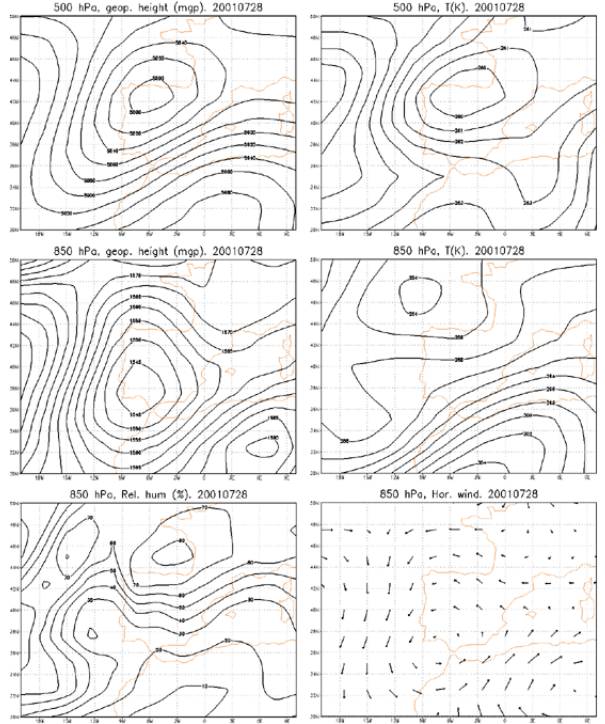
Fig. 8. NCEP reanalysis, 12:00UTC. Date: 28 July 2001, CL3. The atmospheric fields shown are: φ 500 (gpm), T 500 (K), φ 850 (gpm), T 850 (K), rh 850 (%) and wind direction at 850hPa, from left to right.